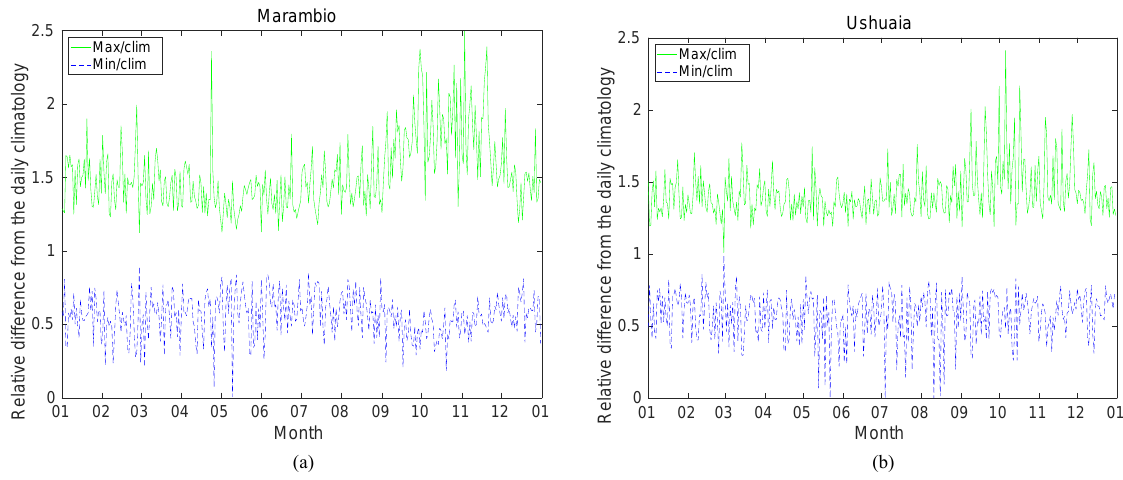
Figure 12. The minimum and maximum erythemally weighted daily doses calculated from respective days of each year of observations divided by the daily climatology in (a) Marambio and (b) Ushuaia during 2000–2010.